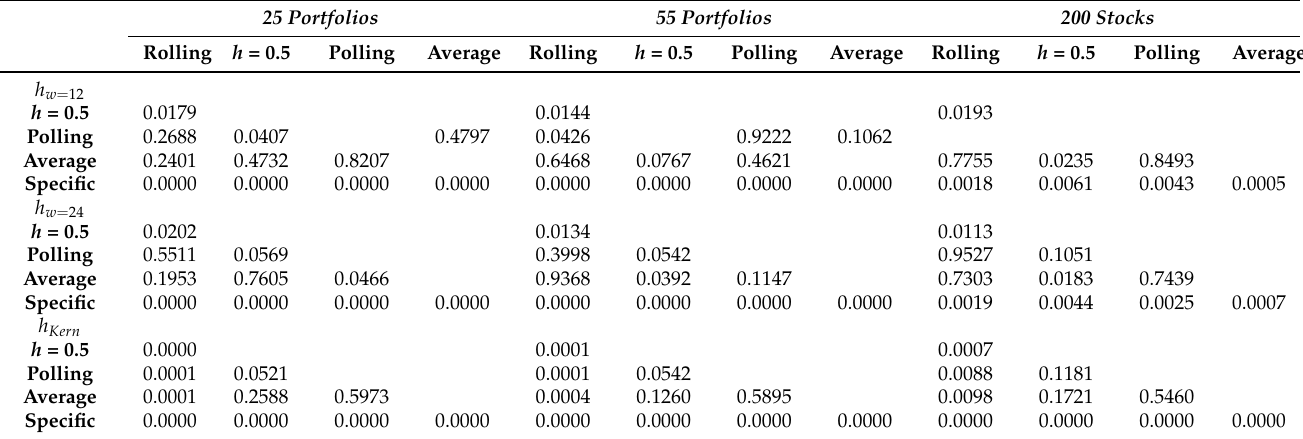
Table 6. Diebold and Mariano test results.